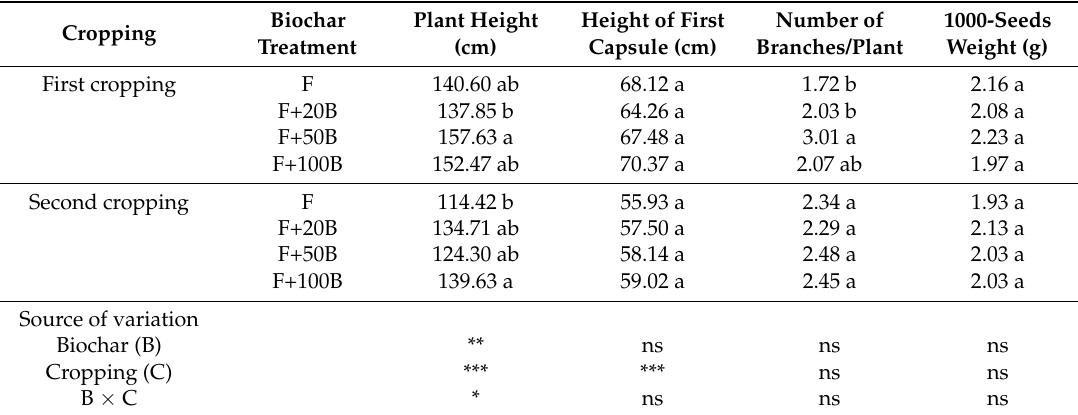
Table 1. The plant height, height of the lowest capsule, number of branches per plant and 1000-seed weight of sesame under the different biochar treatments in different cropping.